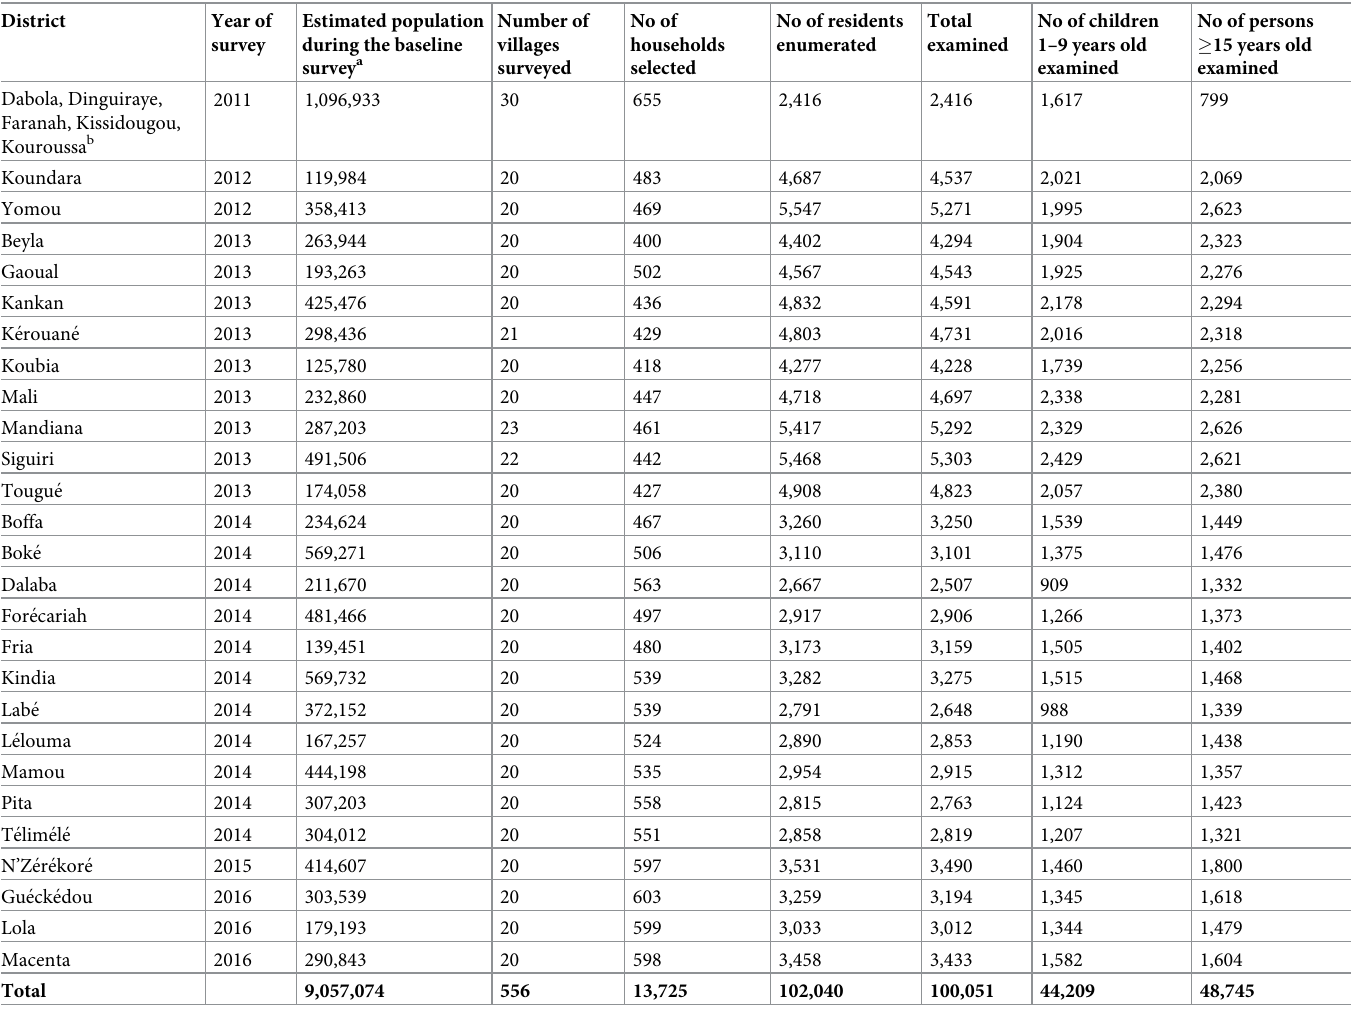
Table 1. Characteristics of surveyed population by evaluation unit in